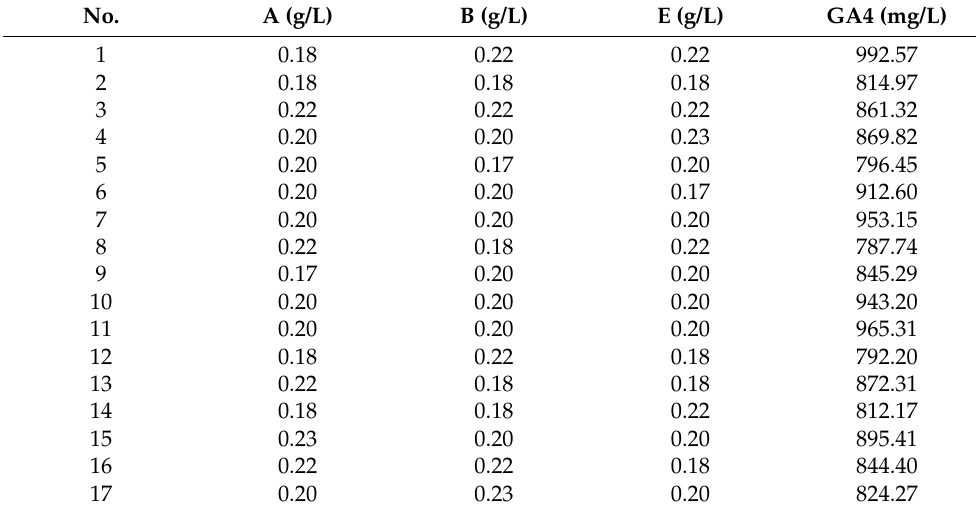
Table 9. Experimental design using CCD of three independent variables with their coded and actual values of GA4 production.